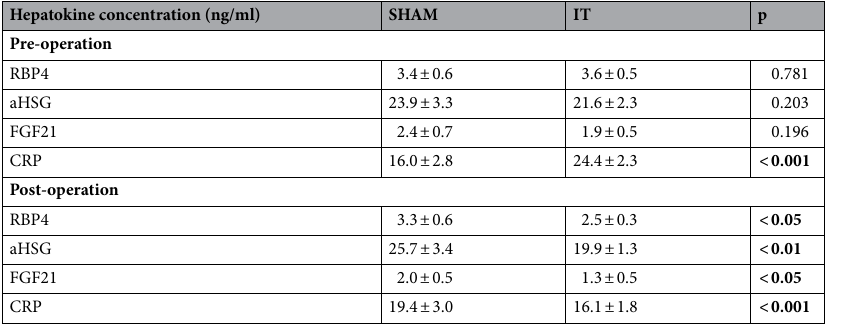
Table 1. Comparison of hepatokines: retinol-binding protein-4 (RBP4), α-2-HS-glycoprotein (aHSG/ fetuin-A), fibroblast growth factor 21 (FGF21), and C-reactive protein (CRP) serum levels in blood of Zucker (Crl:ZUC(ORL)-Lepr fa ) rats before and after control (SHAM) surgery or ileal transposition (IT). The results are presented as mean ± standard deviation. Significance for p-value was set at < 0.05.